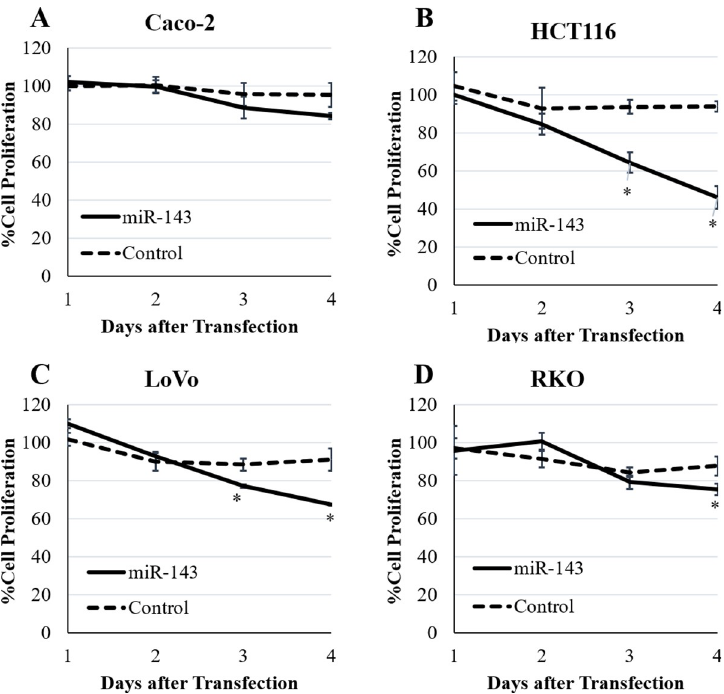
Fig 4. The effect of miR-143-3p on the proliferation of colorectal cancer cells. The effect of miR-143-3p on the cell growth was evaluated at one, two, three, and four days after transfection. There was no significant effect on proliferation of Caco2 ( A ). MiR-143-3p showed significant effect on proliferation of HCT116 ( B ) and LoVo ( C ) at three and four days after transfection ( p < 0.01). MiR-143-3p showed significant effect on proliferation of RKO ( D ) at four days after transfection ( p < 0.01). Results are expressed as mean of the ratio of cell proliferation compared to transfection without miRNA ± standard deviation. � p < 0.01 compared to Control treatment.